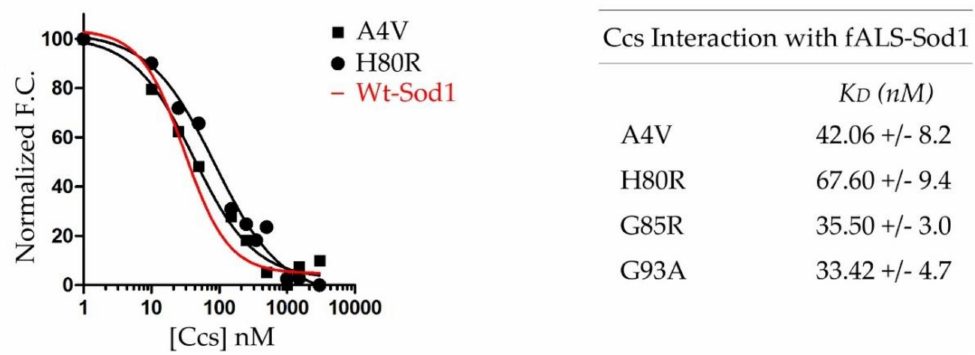
Figure 3. fALS-Sod1 mutants binding with Ccs. The left panel is a combined plot of binding curves for select fALS-Sod1 mutants and Ccs. As shown, the binding curves are comparable to the wT-Sod1 binding curve that we determined previously (red). The right panel shows a list of the fALS-Sod1 mutants that were of focus, here. The K D s are all very similar to that of wild-type Sod1 and show that these particular mutations do not hinder Ccs interaction. All binding assays were performed with the human forms of Sod1 and